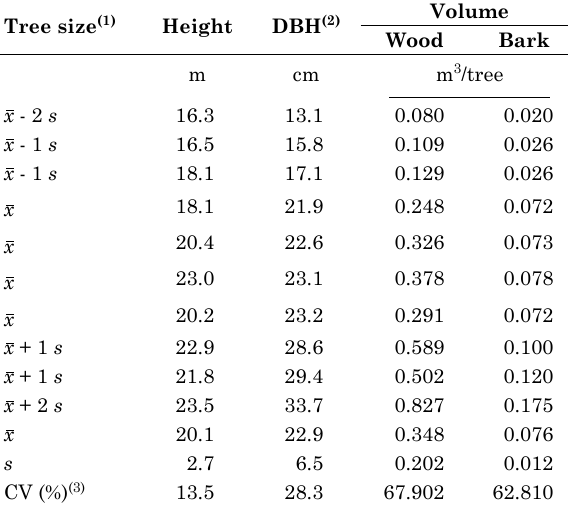
table 1. height, diameter at breast height (dbh), and volume (wood and bark) from sampled trees collected in otacílio costa, Sc,